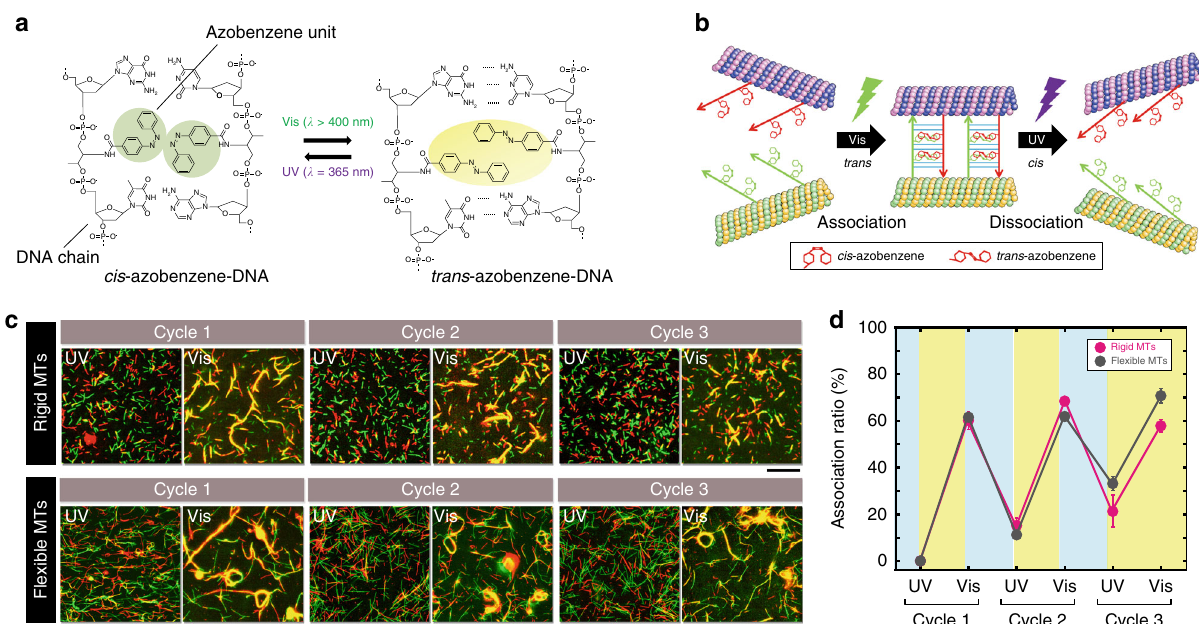
Fig. 5 Light-switched, repeated swarming of MTs. a Reversible hydrogen bonding of photoresponsive DNA ( p -DNA) by light-induced cis – trans isomerization of azobenzene. b Schematic of selective association and dissociation of p -DNA-conjugated MTs under UV and visible light irradiation, respectively. c Visible light ( λ = 480 nm, I = 1.3 mW cm − 2 ) induced isomerization of azobenzene from the cis to the trans form, which resulted in translational swarming of the p -DNA-conjugated rigid MTs with length of 4 ± 2 µ m (average ± s.d.). The swarms were then exposed to UV light ( λ = 365 nm, I = 0.4 mWcm − 2 ) for 6 min that isomerized the azobenzene from the trans to the cis form. The swarms dissociated into single MTs within 12 min of the onset of photoirradiation. This cycle was repeated three times. Visible light irradiation to fl exible MTs with length of 12 ± 1 µ m (average ± s.d.) generated swarms with circular motion. d Changes in the association ratio upon repeated irradiation by visible and UV light. The concentration of red and green MTs was 0.6 µ M each, and the conjugation ratio of p -DNA1 or p -DNA2 to MTs was ~100%. The concentration of kinesin was 0.8 µ M. Scale bars: 20 µ m. Error bar: